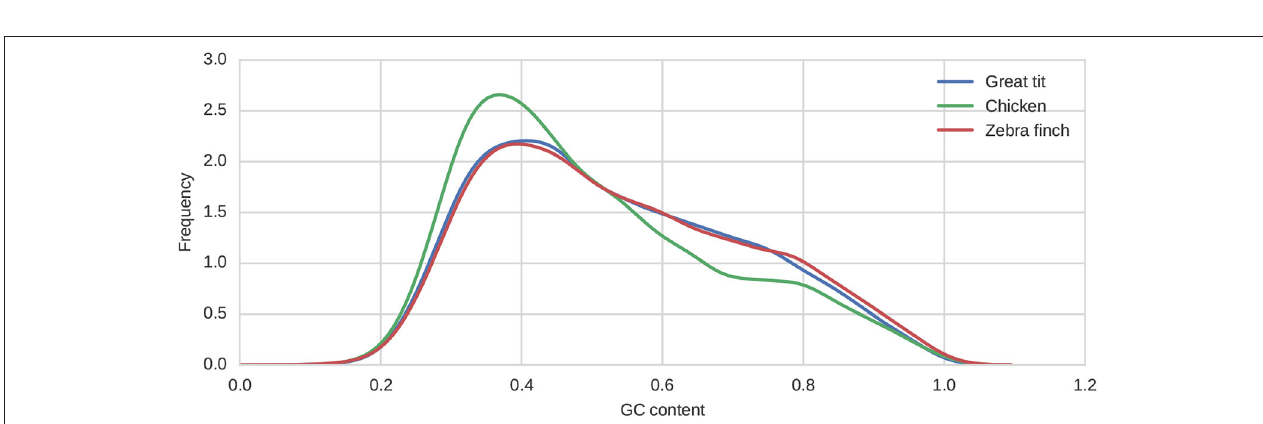
FIGURE 6 | Distribution of GC4 content per gene for the three bird species under consideration. Shown are the kernel density estimations of the histograms as implemented in the python package seaborn.kdeplot.